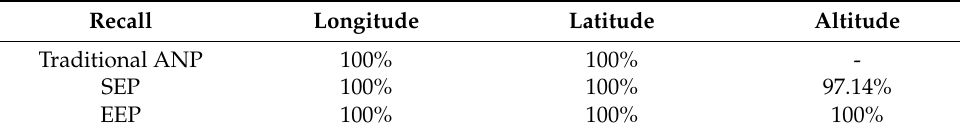
Table 4. Comparison of actual navigation performance evaluation algorithm results.